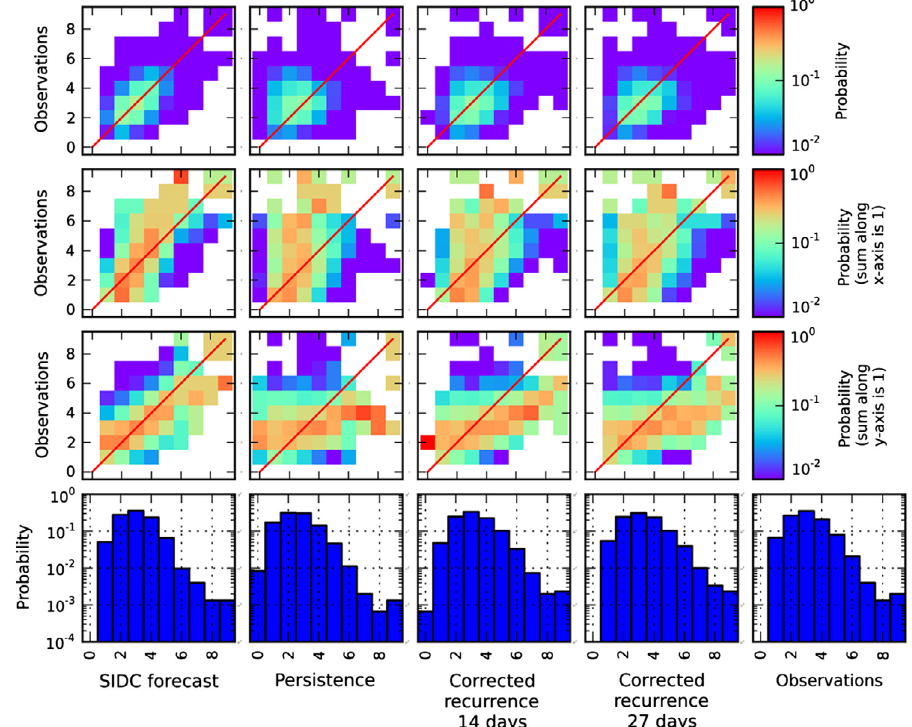
Fig. 6. Matrix plot with the distributions and color grid for the different forecast models of the K -index. Top panel : color grid for the different forecasts (SIDC, persistence, corrected recurrence of 14 and 27 days). The predicted K -level is on the horizontal axis ( x -axis), while the observed one is on the vertical axis ( y -axis). The interpretation of all subplots is analogous to that of Figure 2. The more greenish or reddish the colored square, the more frequent the combination of forecasted and observed flare level occurs. Renormalized version where the sum of the probabilities across the whole grid is 1. The color code on a logarithmic scale is shown on the right side of the panel. Second panel : similar as top panel. Renormalized version where the sum of the probabilities along the x -axis is 1. Third panel : similar as top panel. Renormalized version where the sum of the probabilities along the y -axis is 1. As for K f = 0 of the corrected 14 days recurrence model only K o = 2 is observed, this conditional probability is 1 (red square). Bottom panel : histograms of the different forecast models and observations on a logarithmic